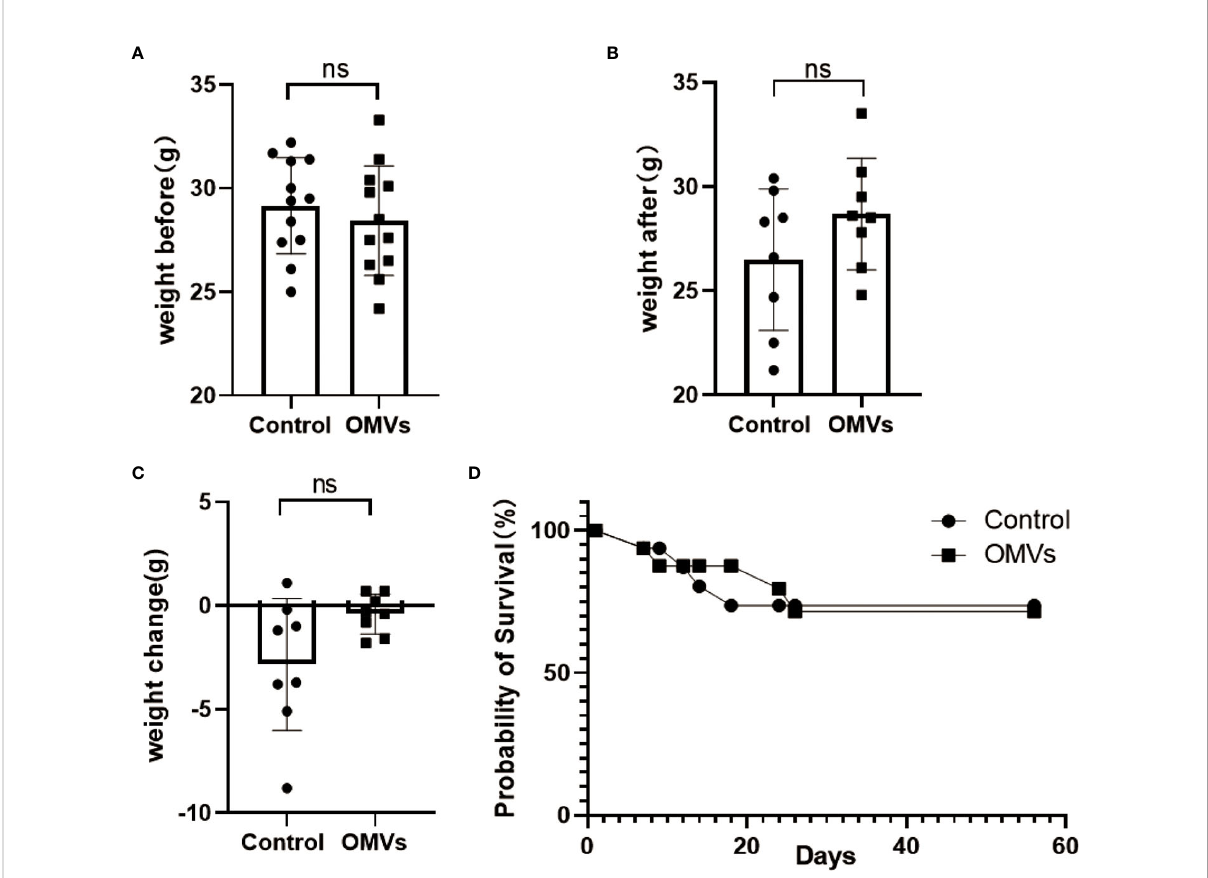
FIGURE 2 Pg OMVs did not affect body weight or survival rate. The mice were weighed before (A) and after (B) treatment, and the weight change (C) is shown. (D) Kaplan – Meier survival plots of mice. Data are presented as mean ± SEM. (ns: P